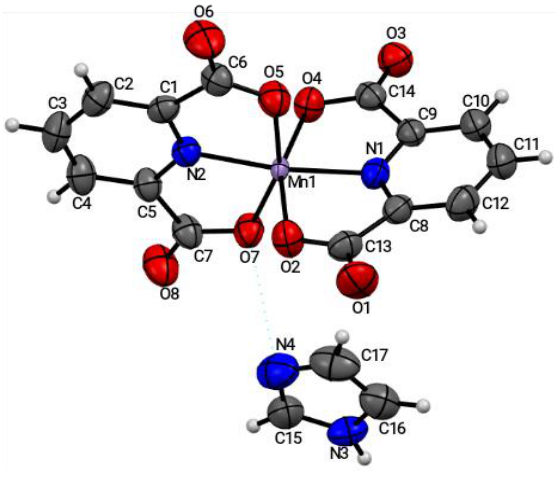
Figure 1. ORTEP diagram of 1 (010). Red = oxygen, Blue = nitrogen, Grey = carbon, Purple = man- ganese